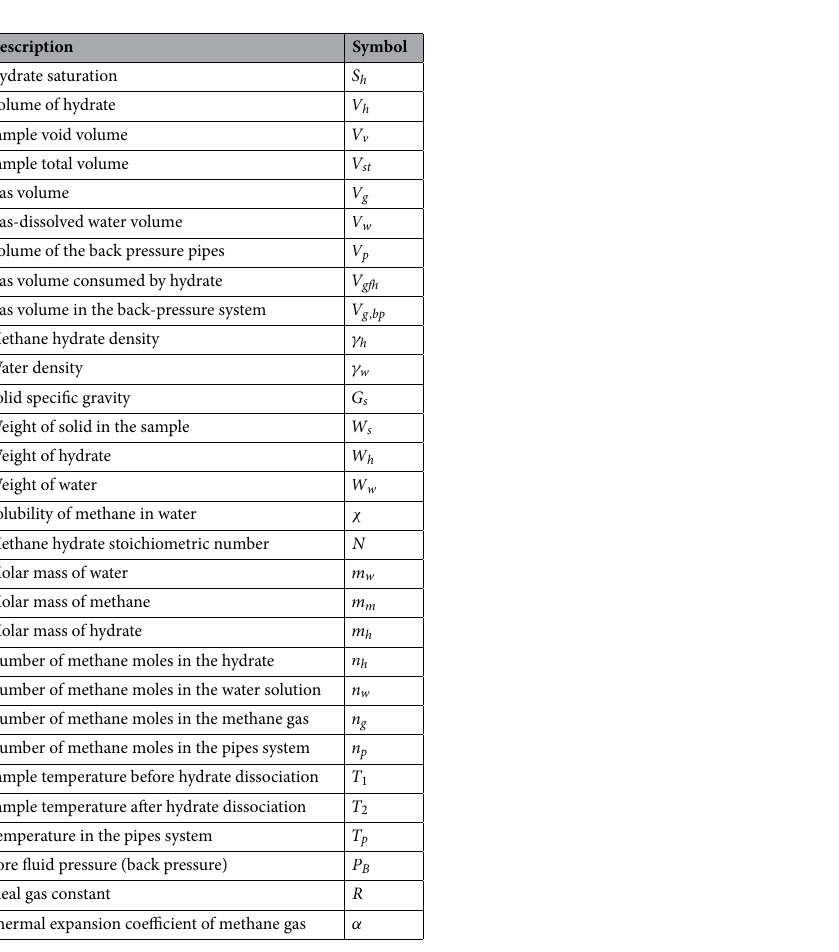
Table 1. Parameters used to calculate the hydrate saturation (Eqs.